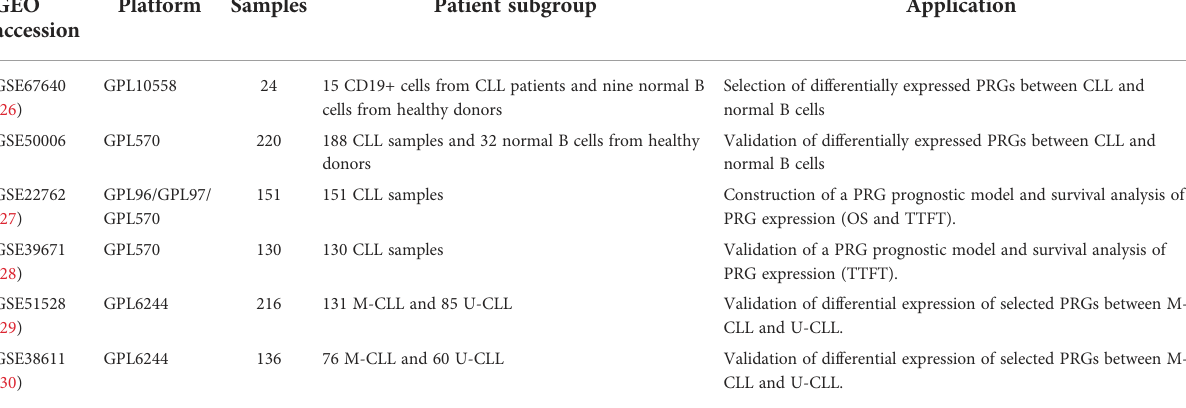
TABLE 1 The summary of GEO datasets used in the present